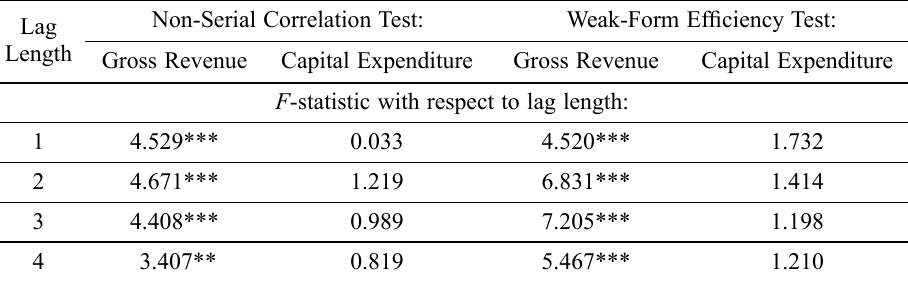
Table 3. Results of non-serial correlation and weak-form efficiency Tests Non-Serial Correlation Lag Length